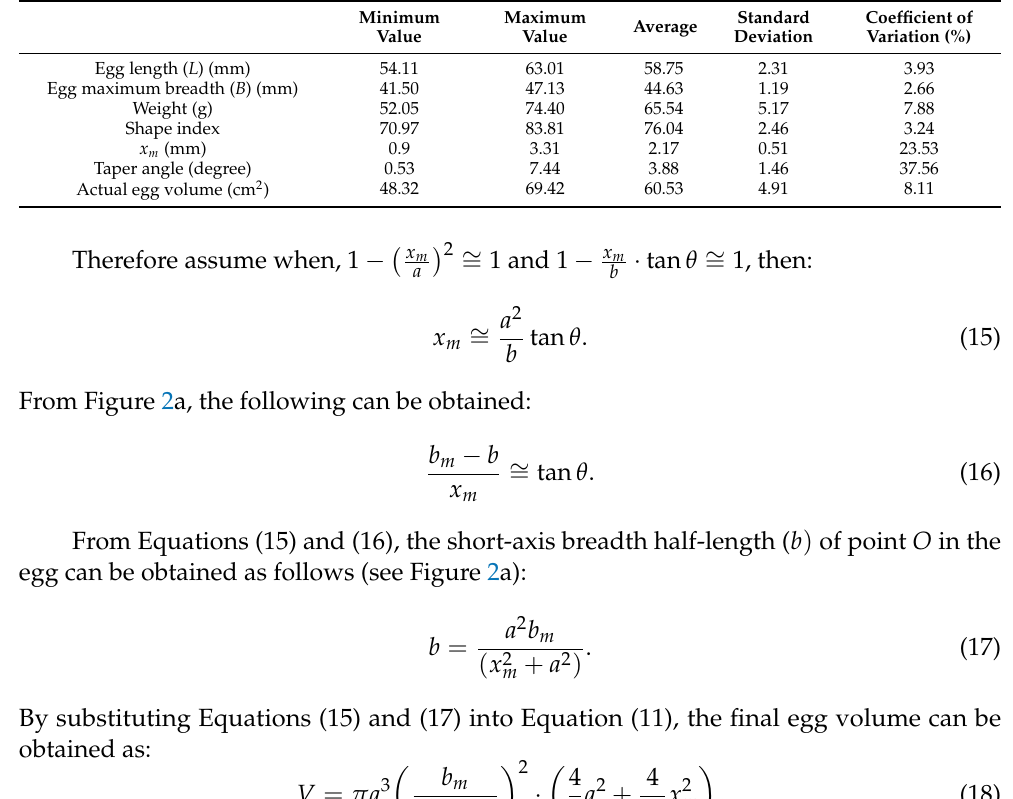
Minimum Maximum Value Value Average